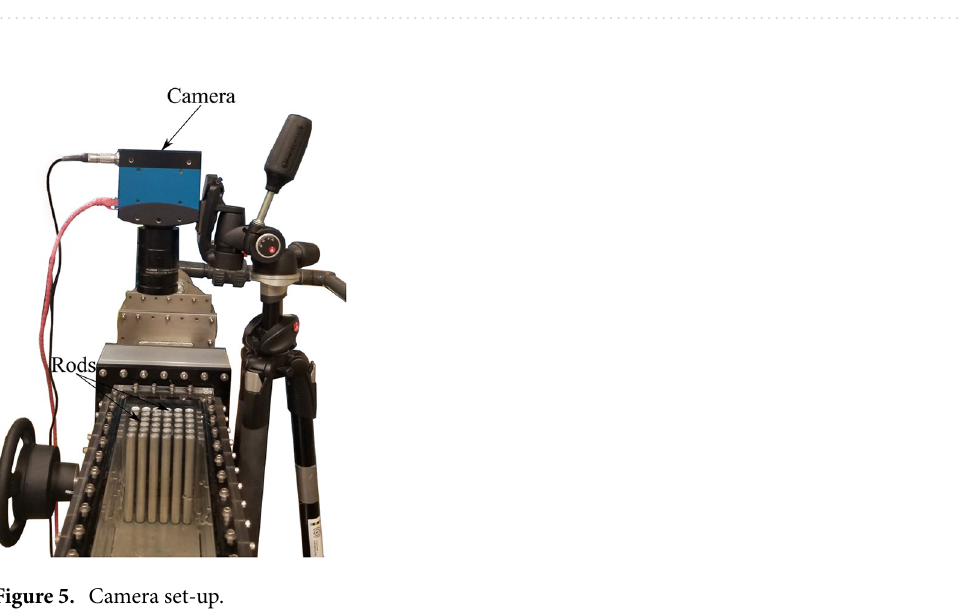
Figure 4. Test loop setup.